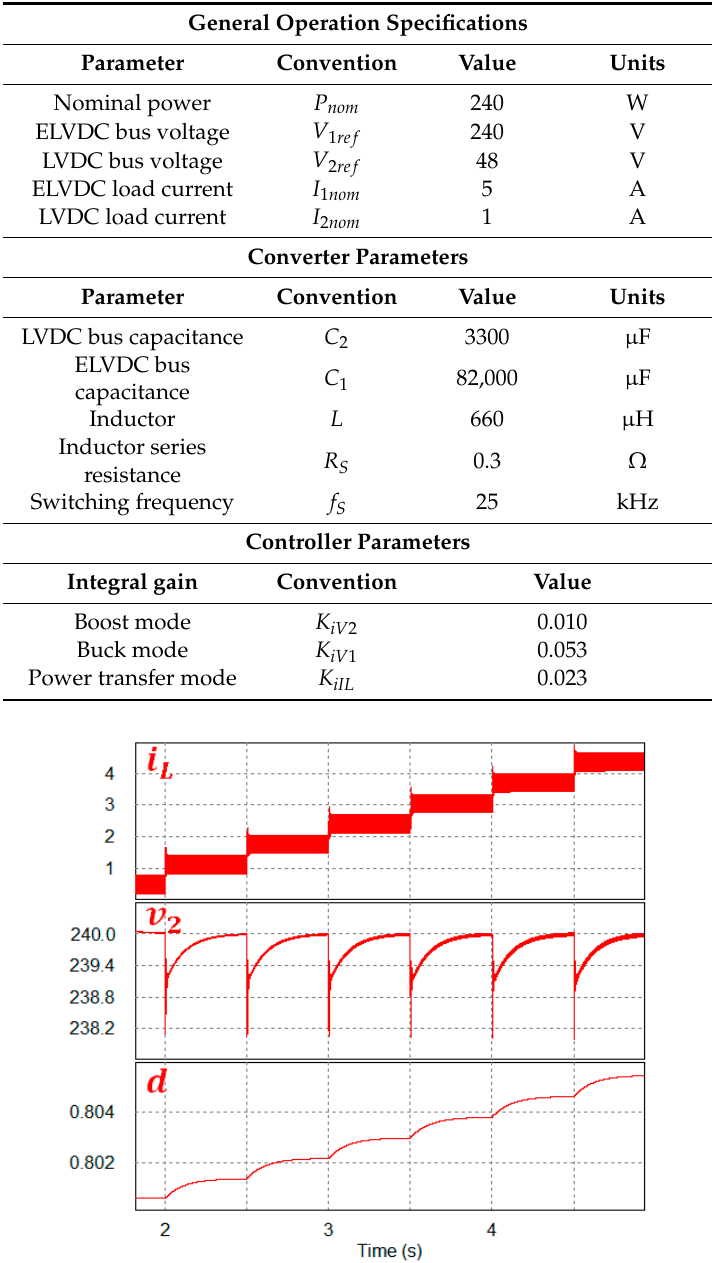
Figure 11. Simulated waveforms during validation test of the boost mode.